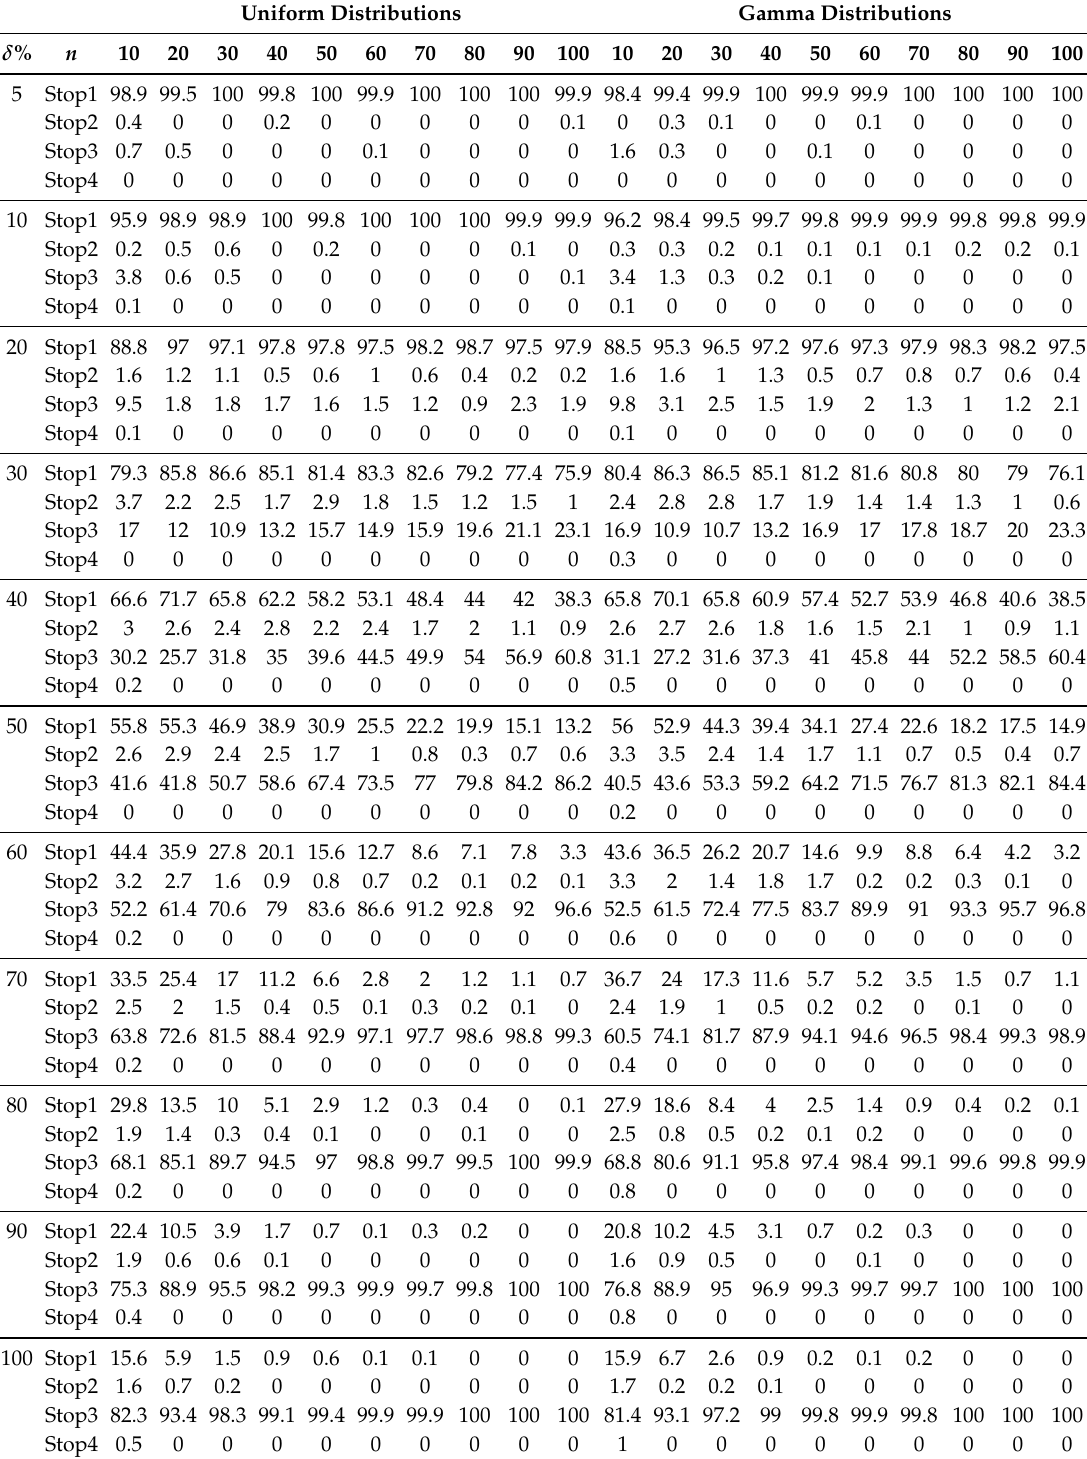
Table A9. Computational results for randomly generated instances with the ratio 10%:10%:10%:70% of the numbers of jobs in the subsets J 1 , J 2 , J 1,2 and J 2,1 of the job set J